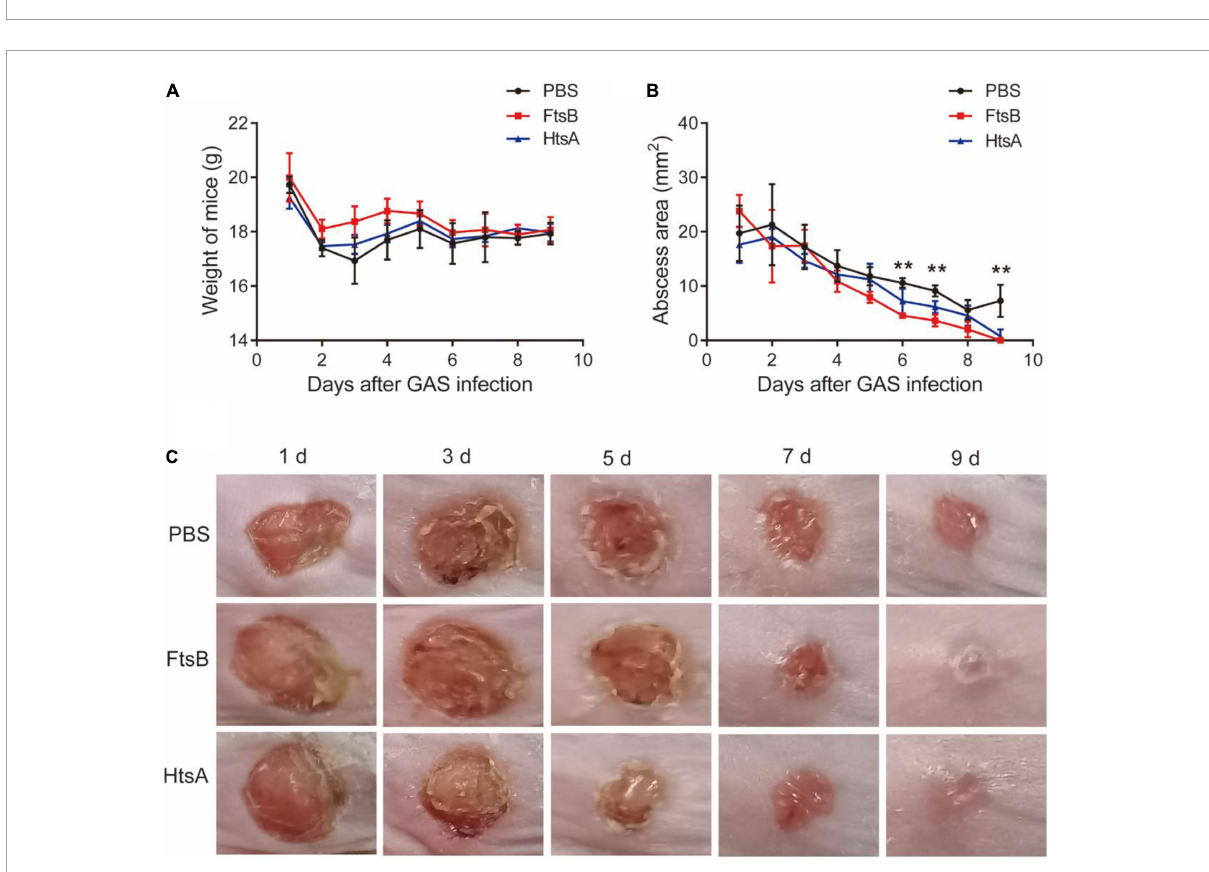
FIGURE5 Immunization with the FtsB protein decreases the size of abscesses caused by S. pyogenes in a murine skin infection model. (A) The body weight of the mice. (B) The size of abscesses in mice. (C) Representative mouse skin lesions. n = 5 mice per group, ** p < 0.01 represent FtsB vaccinated group vs. PBS control